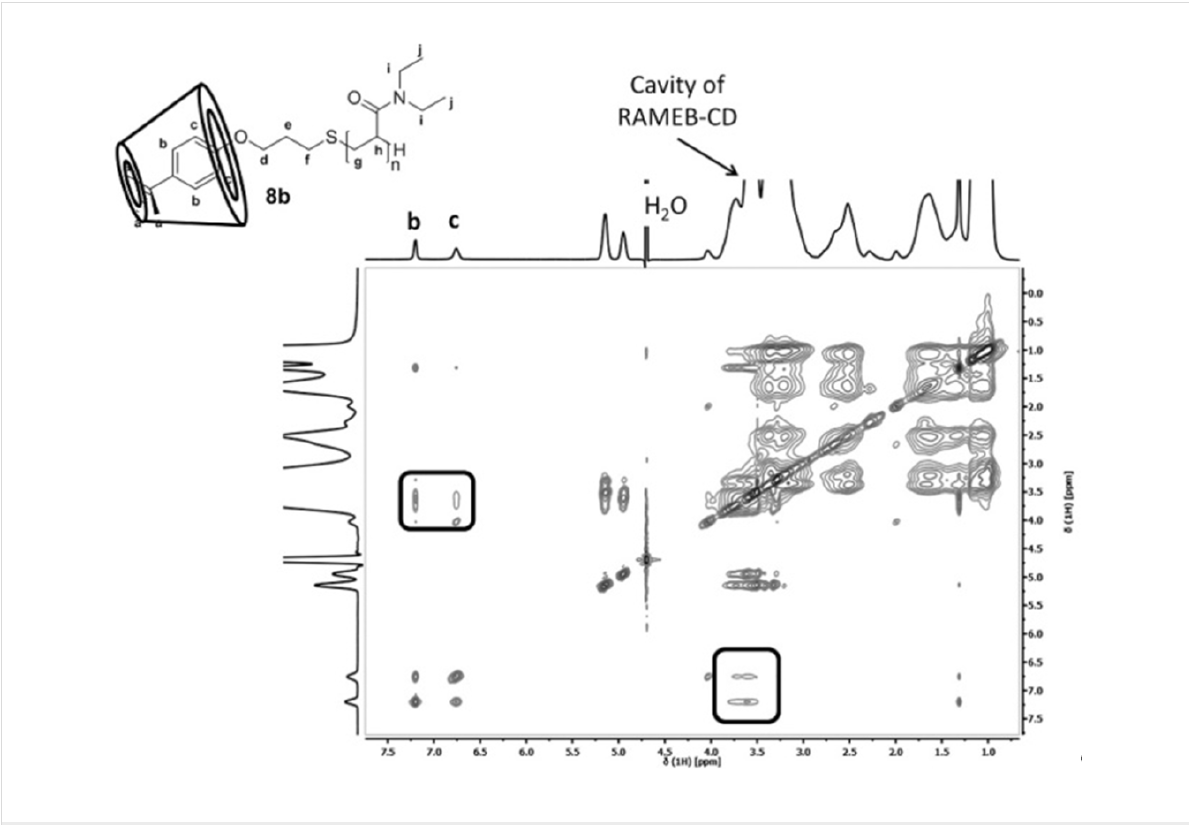
Figure 7: 2D NMR NOESY spectrum of polymer 8b with two equivalents RAMEB-CD in D 2 O (600 MHz, rt).